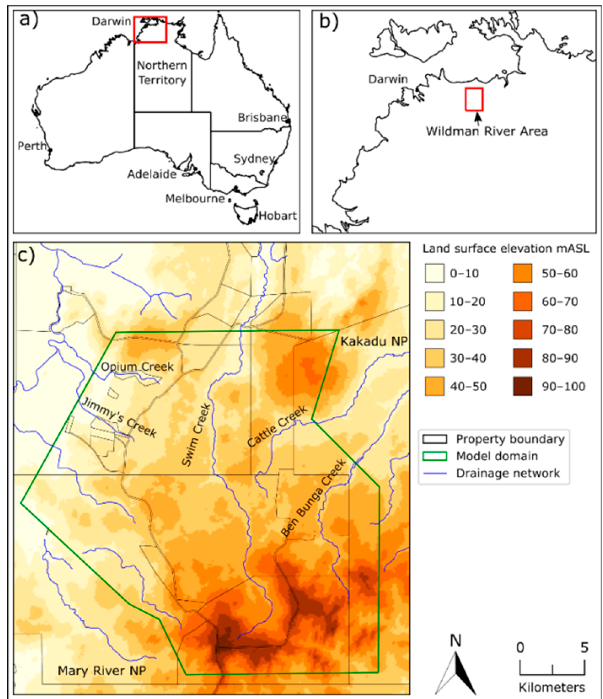
Figure 2. The study area is a part of the Wildman River area located between Mary River and Kakadu National Park in Northern Territory, Australia. ( a ) Australia, ( b ) North-western part of Northern Territory, ( c ) Wildman River Area.